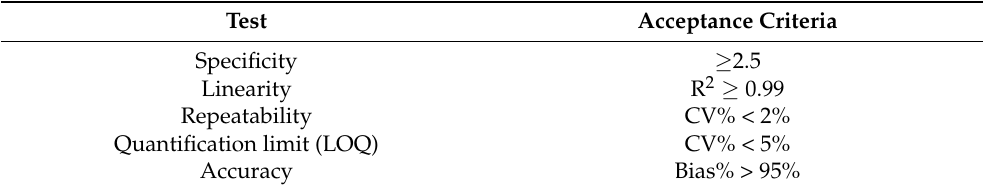
Table 2. Tests and acceptance criteria in determining chemical purity using HPLC.